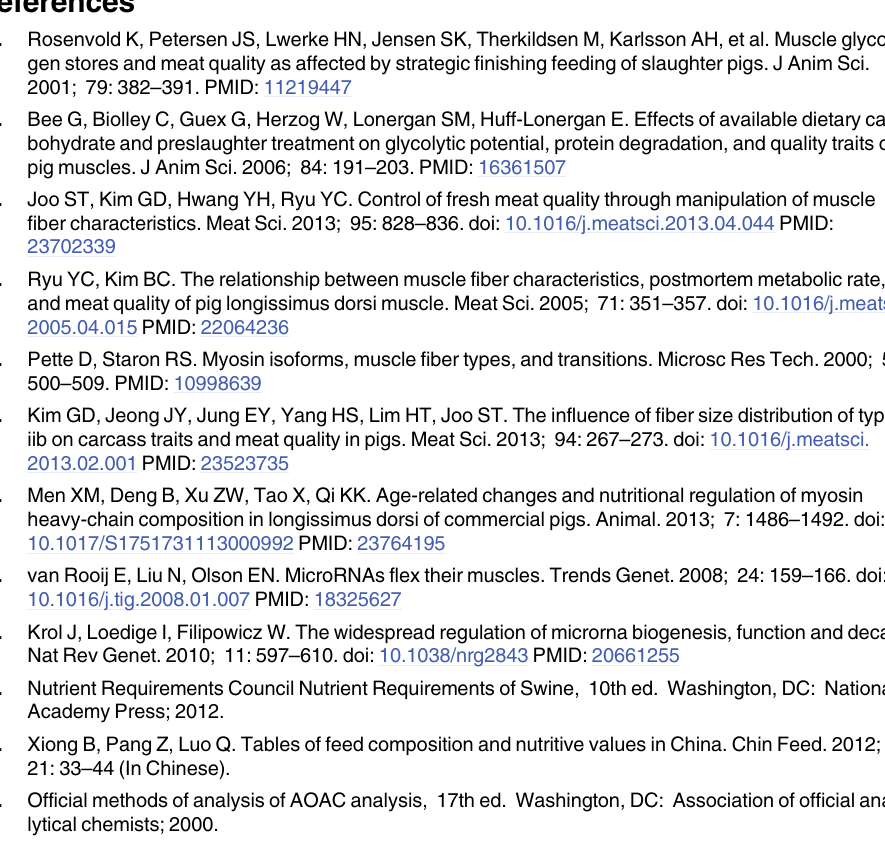
S3 Table. The minimal data for muscle glycolytic potential of finishing pigs. S4 Table. The minimal data for meat quality of finishing pigs. S5 Table. The minimal data for mRNA expressions of MyHC isoform genes. S6 Table. The minimal data for expressions of miR23a, PGC-1 α and MEF2C. S7 Table. The minimal data for expressions of miR499 and Sox6. S8 Table. The minimal data for expressions of miR208b, Sp3 and